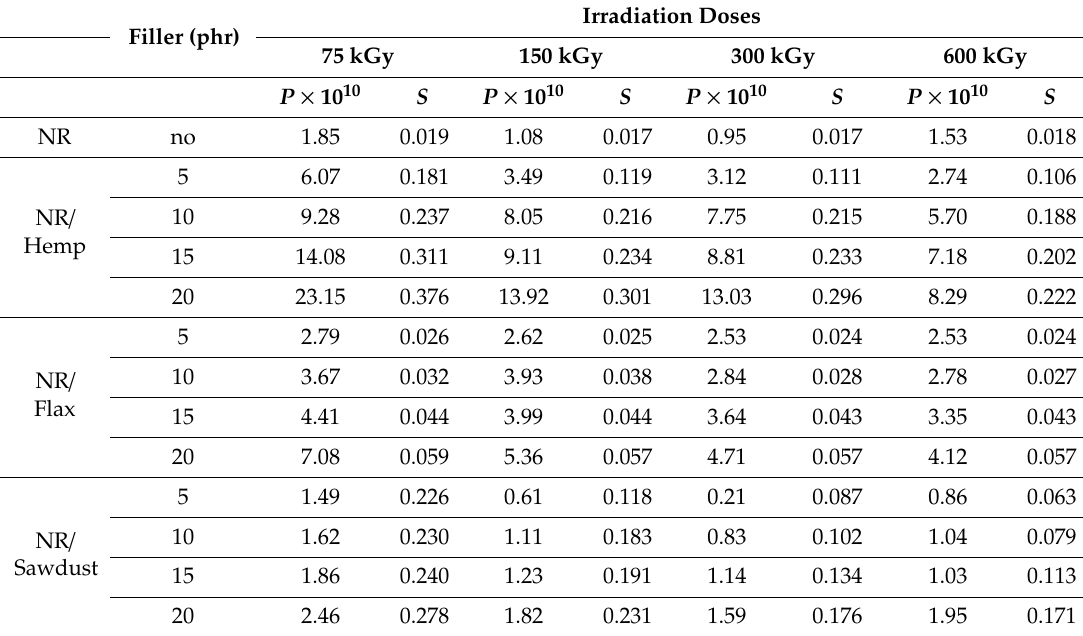
Table 7. Values of P × 10 10 · m 2 s − 1 and S (%) as a function of irradiation